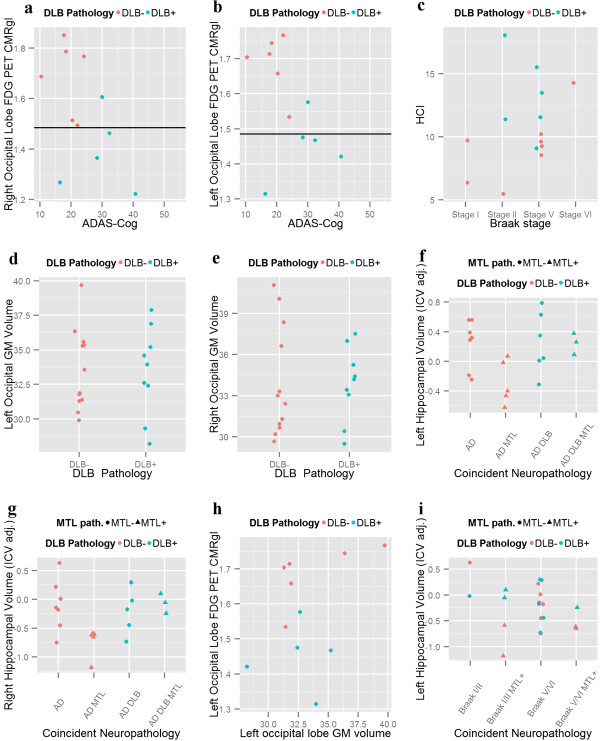
Neuroimaging correlates. a) Right and b) Left occipital lobe FDG PET CMRgI stratified by presence or absence of coincident DLB and their relationship to ADAS-Cog measure, c) FDG-PET HCI stratified by presence or absence of coincident DLB and its relationship to ADAS-Cog measure. d) Left and e) Right occipital GM volume stratified by presence or absence of coincident DLB. f) Left and g) Right hippocampal volume stratified by neuropathologically defined groups. h) Occipital lobe GM volume and FDG PET CMRgI. i) Left hippocampal volume stratified by Braak stage and coincident MTL pathology.